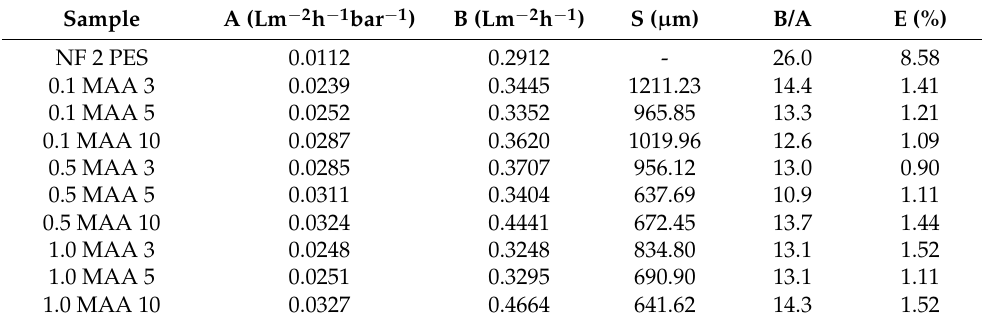
Table 4. Intrinsic characteristics (A, B, S) of the unmodified and UV − grafted membranes.